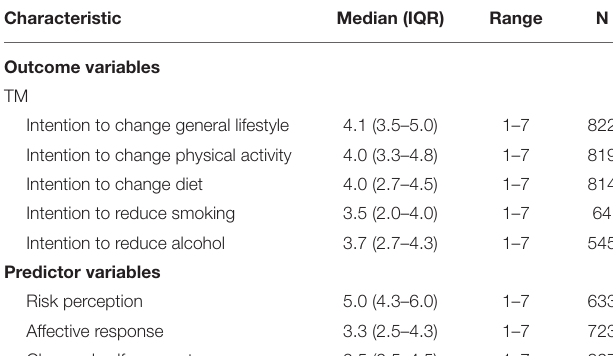
TABLE 3 | Pearson’s correlation between